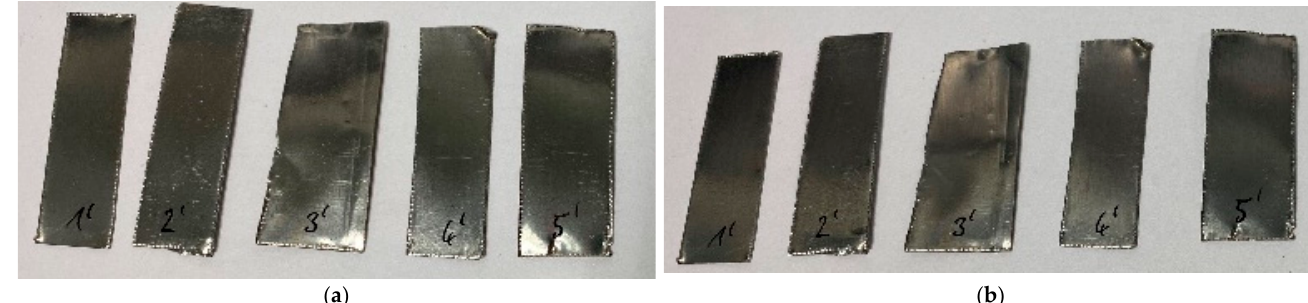
Figure 2. Steel strips before ( a ) and one week after oxidative low-pressure plasma treatment ( b ). The samples on the right-hand picture were treated for 12 (1 ′ ), 24 (2 ′ ), 36 (3 ′ ), 48 (4 ′ ), and 60 (5 ′ ) min. No plasma e ff ect was visible on the steel strips.